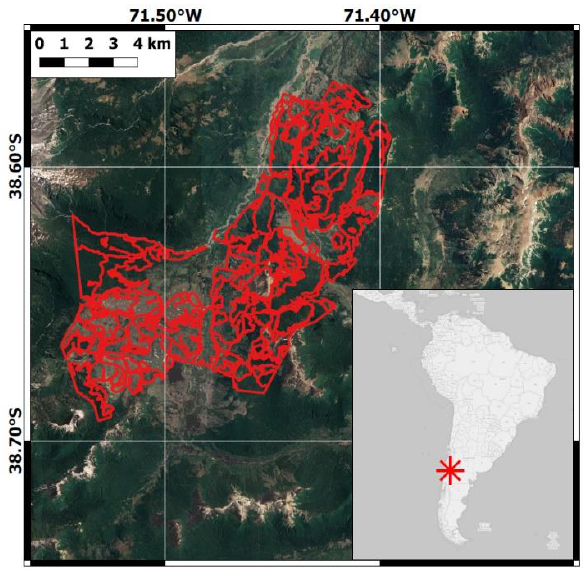
Figure 2. Study area, La Fusta,